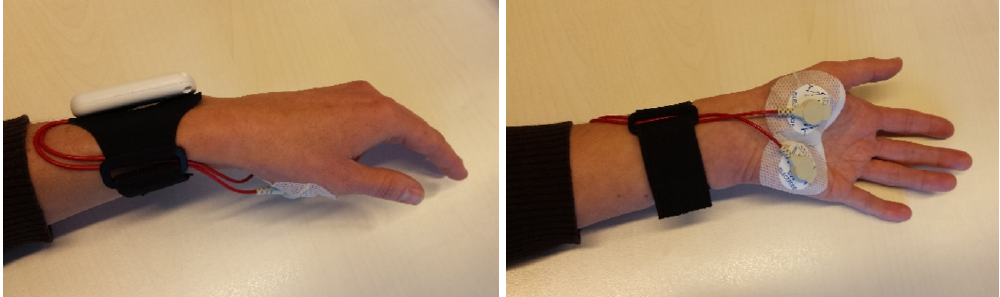
Figure 1. Electrodermal activity (EDA) sensor used in the experiment (EdaMove